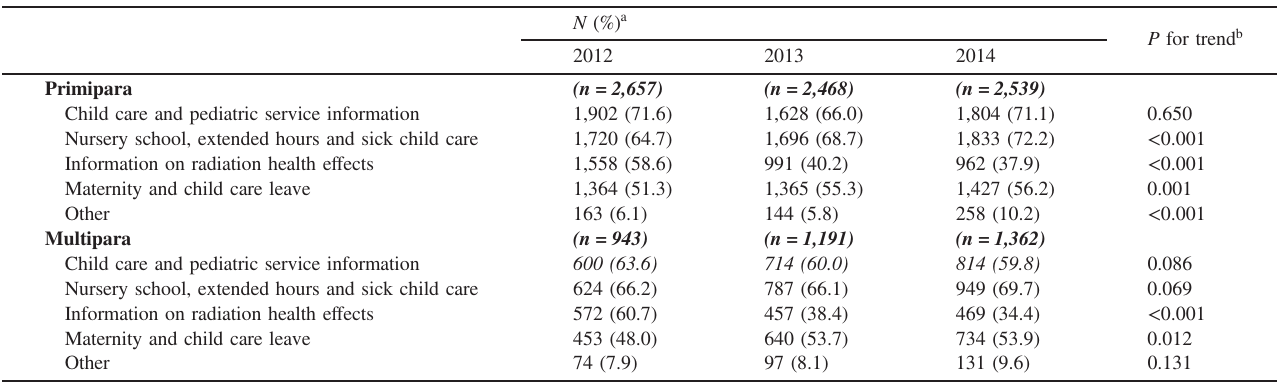
Table 5. Service demands among mothers with intention of future pregnancy by